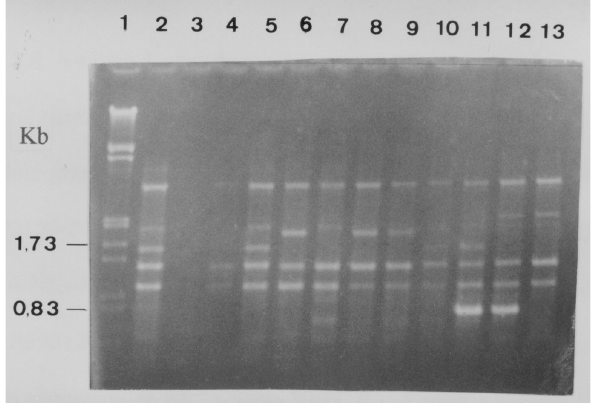
Figure 4 - Random amplified polymorphic DNA from 12 isolates of Drechslera tritici-repentis using primer OPC13. Lanes are as follows: (1) λ Hind III- Eco RI; (2) CEP24-Selbach; (3) E24-Butiá Gr./Sertão; (4) E16- Selbach; (5) E16-Não-Me-ToqueII; (6) E16-Coxilha; (7) C19-Cruz Alta; (8) PF90120- Passo Fundo; (9) E16-Vacaria; (10) E16-Ronda Alta; (11) BR23-Santa Rosa; (12) E15-Lagoa Vermelha; (13) E16-Não-Me-ToqueI. The numbers on the left are the lengths of the marker bands in kilobases.